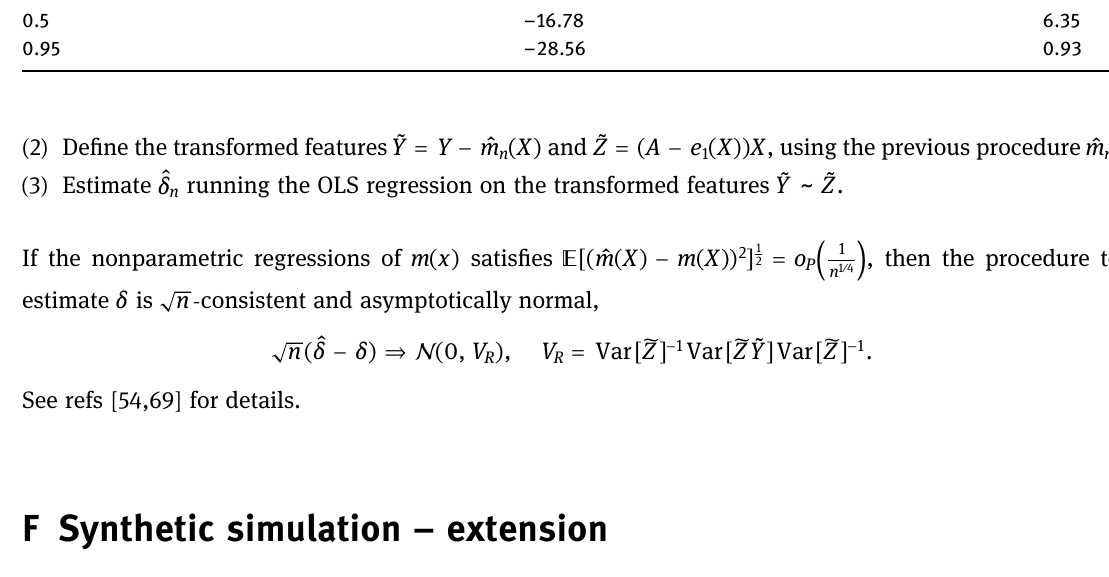
Table A1: Coe ffi cients estimated in the simulation : Simulation with X 1 as the missing covariate repeated 100 times, means of estimated coe ffi cients for X 5 and bias on ATE using the Robinson procedure ρ X X , 1 5